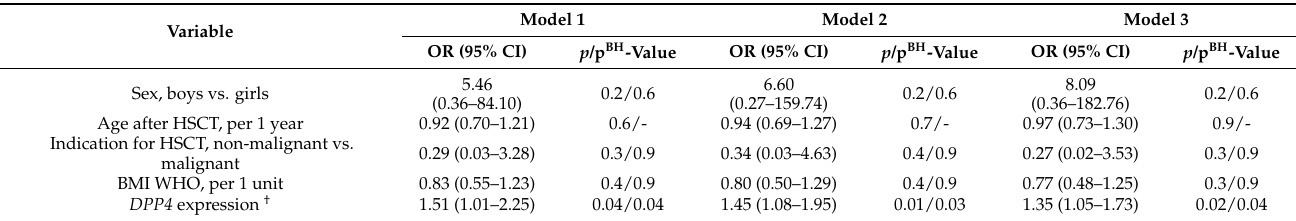
Table 10. The multiple logistic regression models predicting the presence of dyslipidemia after the HSCT procedure. Model 1 Model Variable